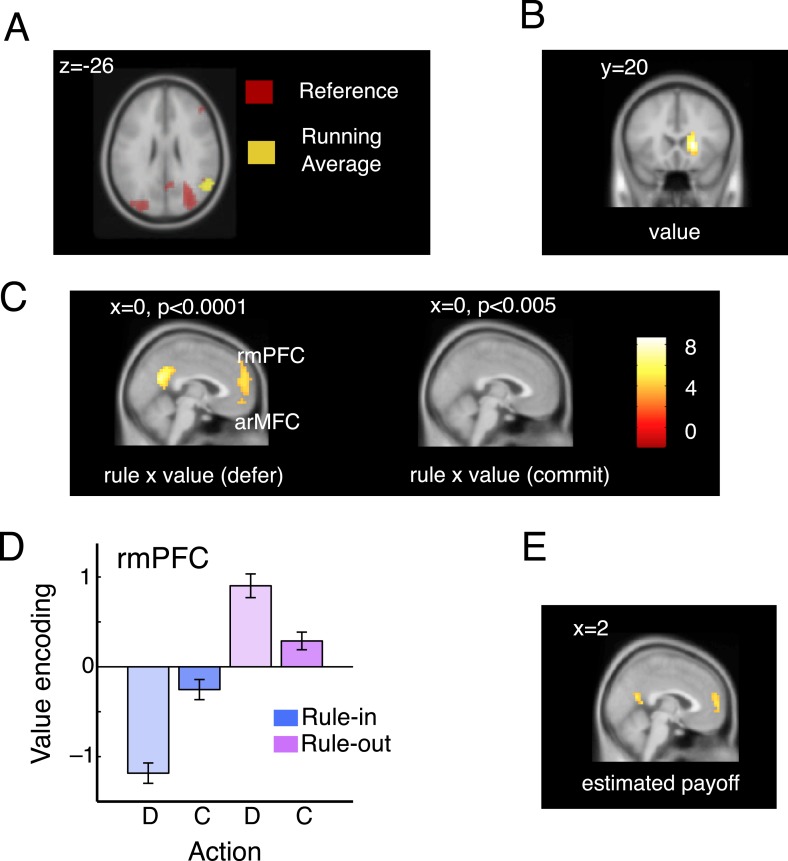
Imaging data: model validation and rmPFC.(A). Overlapping activations in the parietal cortex elicited by the current bandit running average (yellow; peak: 58, −60, 26; t(19) = 4.78, p < 0.0002) and reference (red; peak: 34, −68, 22; t(19) = 6.17, p < 0.00001). (B) In the right caudate nucleus, we also observed a representation of the difference between these two quantities, that is, voxels that co-varied with the DVcur − ave but did not vary according to the rule type or decision (main effect of the value signal; peak: 18, 20, 2; t(19) = 6.63, p < 0.00001). (C) Voxels responding to the interaction of rule and value on defer trials (left, at p < 0.0001) and commit trials (right, at p < 0.001). Value is encoded (in the frame of reference of the rule) only on defer trials. (D) Mean parameter estimates, derived by regressing bandit value on the BOLD signal from within an independently-defined ROI in the rmPFC, separately for defer and commit decision under each rule. To ensure independence, ROIs were defined individually for each participant as the peak voxel responding within the region in the remaining 19 participants. All significant voxels are visualized at p < 0.001 and survive correction for multiple comparisons across the brain. (E) Parameter estimates from a regressor encoding the value of the asset pool (estimated final payoff).